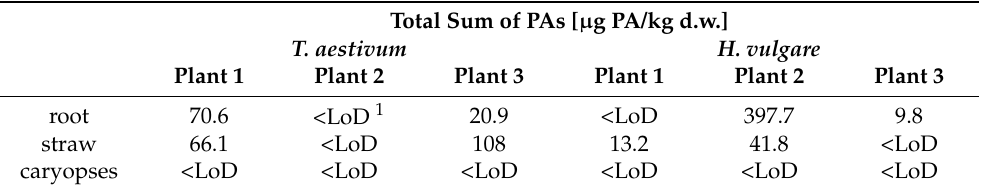
Table 6. PA-content caused by horizontal PA-transfer to non-PA-accessory plants originating from re-germination of hibernated L. squarrosa seeds maintained in the soil after two years. Total Sum of PAs [ µ g PA/kg